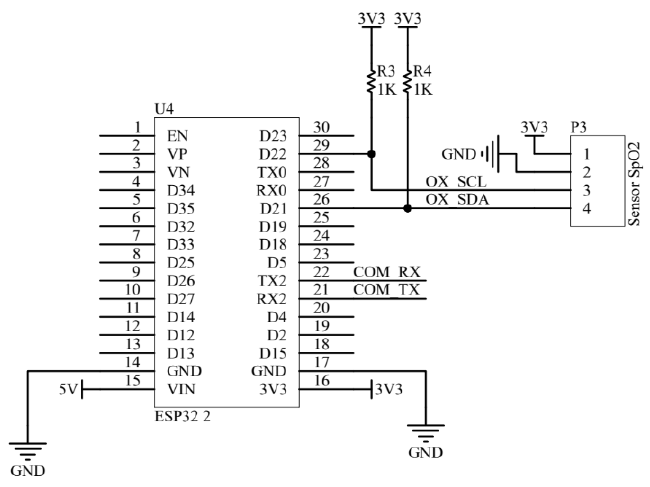
Figure 6. Max30102 circuit connected with ESP322.